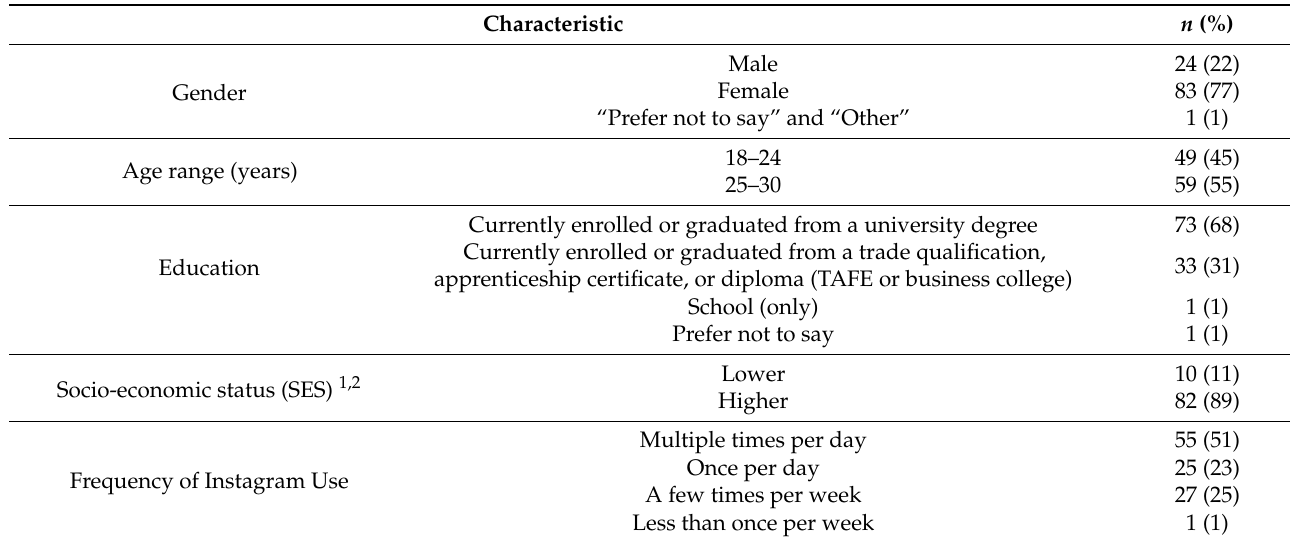
Figure 2. Participant flow diagram in the Instagram survey study. Table 1. Instagram survey participant characteristics ( n = 108).